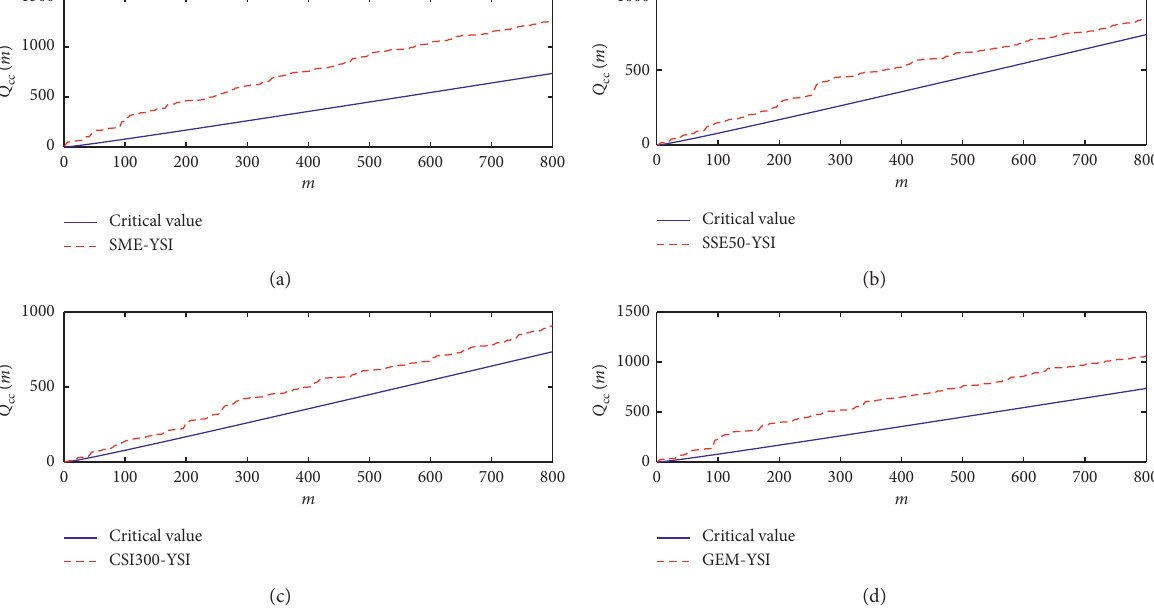
( m ) for market participation willingness and Chinese stock market volume. cc